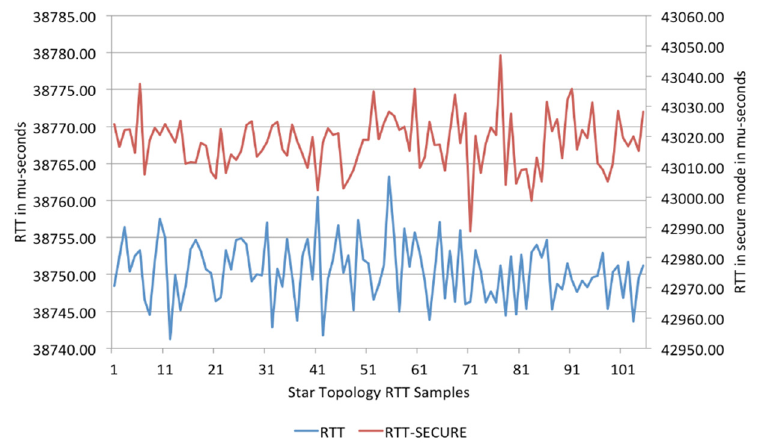
Figure 11. RTT from L-SM to NOC in a star topology (one hop).